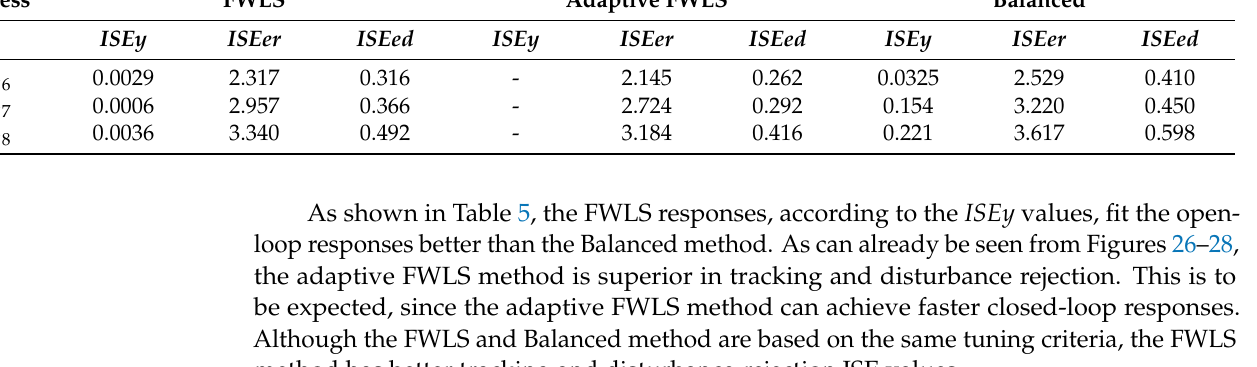
Table 5. ISE values for tracking and disturbance rejection for considered models.